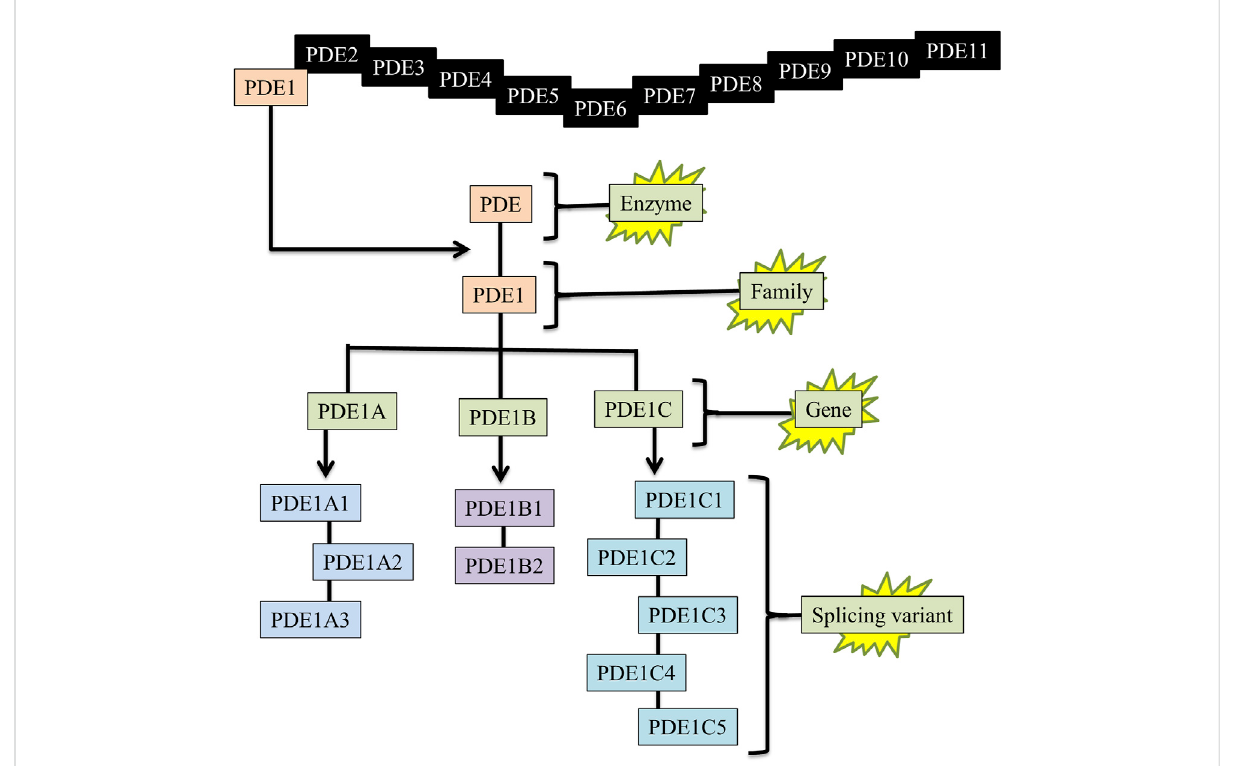
Enzyme, family, gene, and splicing variantsof PDE1. PDE = Phosphodiesterase, PDE1 = Phosphodiesterase-1, PDE1A1 = (PDEenzyme, 1-family, A-gene, 1-splicing